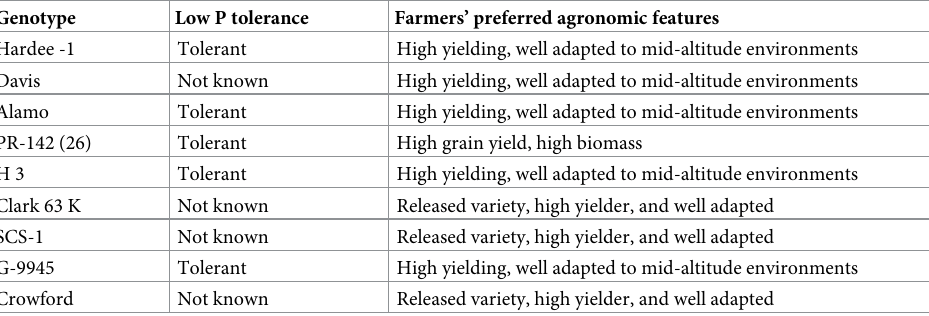
Table 1. Characteristics of the nine soybean parental genotypes used in the present